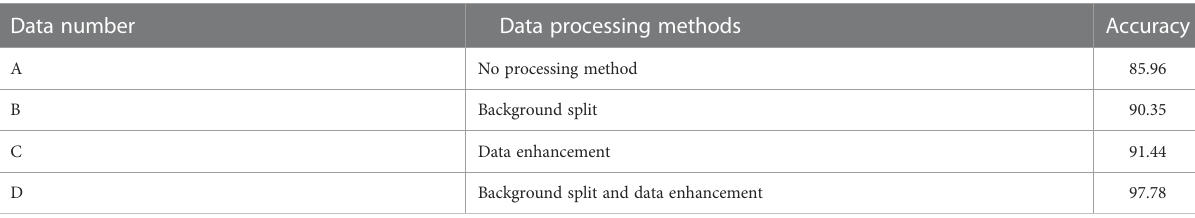
TABLE 3 Results of the four datasets run in our model.